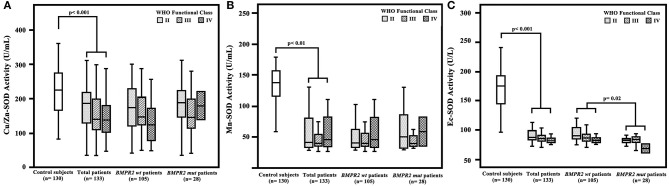
Plasma superoxide dismutase (SOD) activity in patients with idiopathic pulmonary arterial hypertension (IPAH), control subjects, patients with BMPR2 mutation (BMPR2 mut), and those with wild-type BMPR2 (BMPR2 wt), associated with WHO functional class. (A) The plasma Cu/Zn level was significantly decreased in patients with IPAH compared to that in the control subjects. (B) The Mn-SOD activity was significantly lower in patients with IPAH compared to that in the control subjects. (C) The Ec-SOD activities in patients with IPAH were significantly lower compared to those in the control subjects. The Ec-SOD activity in patients of the BMPR2 mut group was statistically decreased compared to that in patients of the BMPR2 wt group. The line through the center of the boxes represents the median. BMPR 2, bone morphogenetic protein receptor type 2; Cu/Zn-SOD, copper–zinc superoxide dismutase; Mn-SOD, manganese superoxide dismutase; Ec-SOD, extracellular form of Cu/Zn superoxide dismutase.